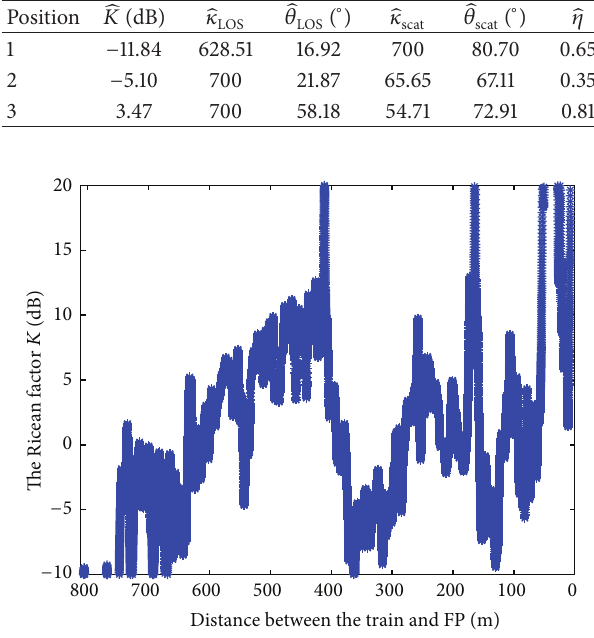
Figure 4: Ricean factor versus the